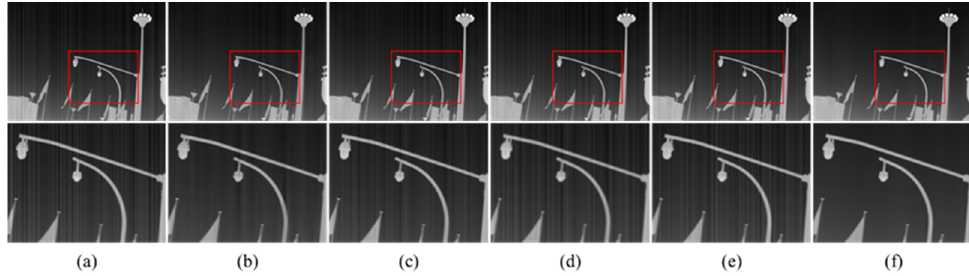
Figure 8. The NUC results of different methods. Top: raw infrared image and the NUC results; Bottom: Zoom-in views on the highlighted area. ( a ) The noise infrared images with intensity of 0.03; ( b ) 1DGF [33]; ( c ) SNRCNN [15]; ( d ) DLS-NUC [16]; ( e ) ICSRN [17]; ( f ) Our method.